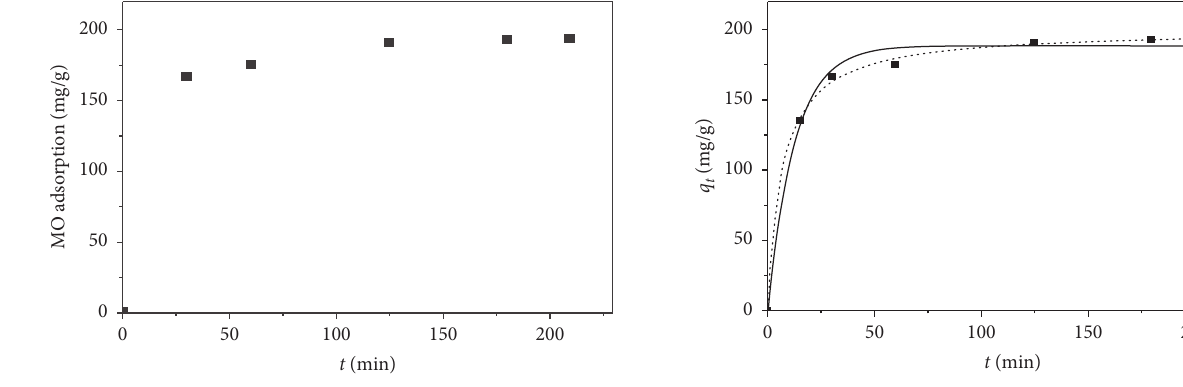
Figure 1: Effect of contact time on the MO adsorption onto ac- tivated carbon ( C 0 � 100mg/L; adsorbent dose � 0.2g/L; pH ∼ 7; T � 20 ° C).